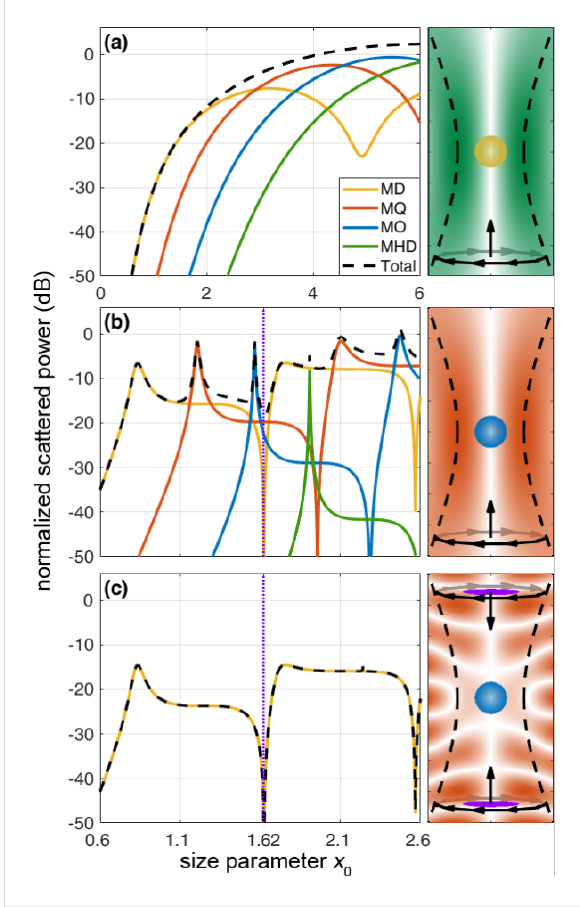
Figure 1: Plots of the normalized scattered power ( P sca / P inc ) in dB, decomposed into its multipolar contributions, as a function of the size parameter of the particle, x 0 . a) Golden sphere at the focal point of an azimuthally polarized, rotationally symmetric beam at λ 0 = 500 nm. b) Silicon sphere at the focal point of an azimuthally polarized, rotation- ally symmetric beam at λ 0 = 1550 nm. c) Silicon sphere at the focal point of two counterpropagating, out of phase, azimuthally polarized, rotationally symmetric beams, modulated by the proposed phase mask, at λ 0 = 1550 nm. Purple dotted lines indicate the first anapole condition for a sphere of size x 0 = 1.62. On the right-hand side, there are illustrations of the actual E-field intensity of the excitation over a window of 2 × 4 wavelengths at the focal region, on the ρ O z plane, with a sphere of size x 0 = 1.62 placed at the focal